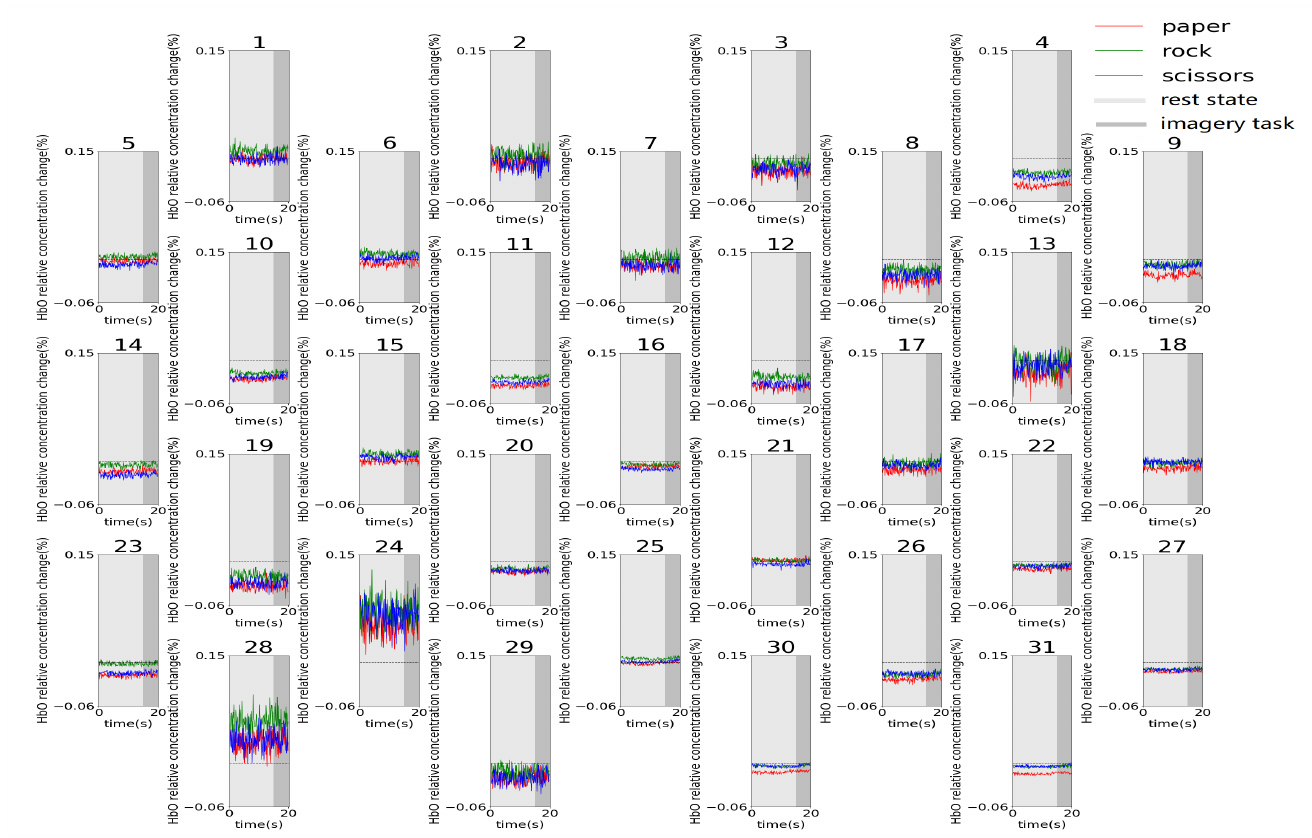
Figure 7. The averaged responses of raw fNIRS data for the different tasks among all